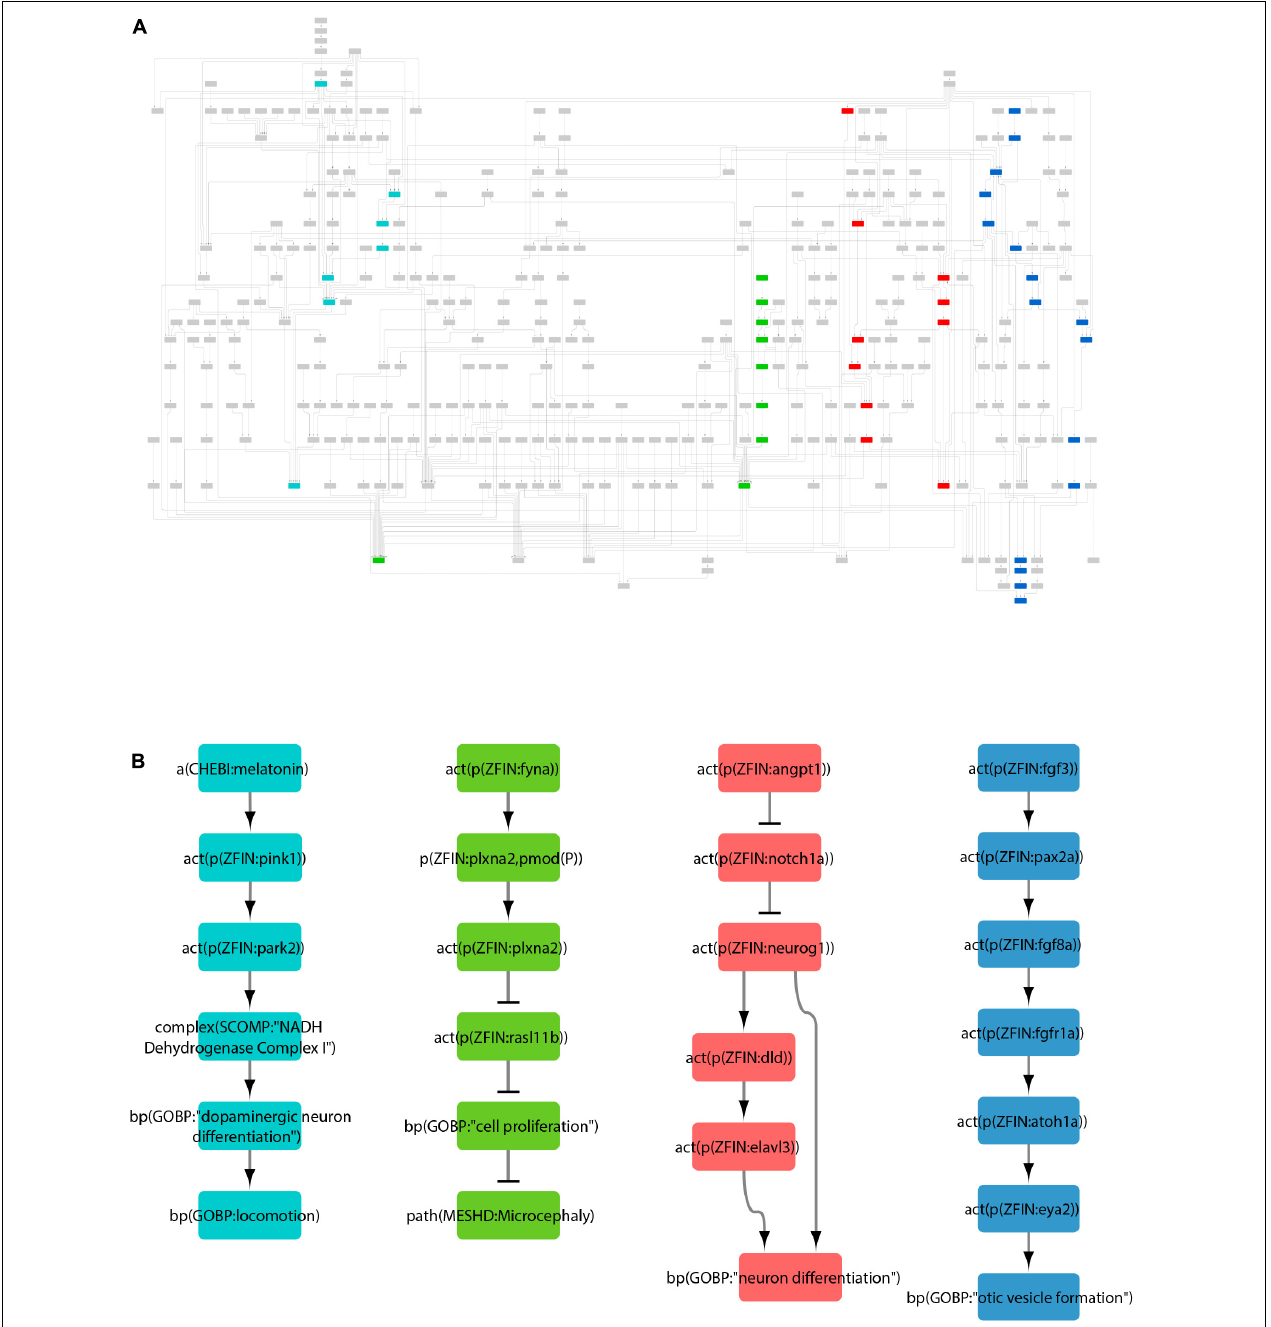
FIGURE 2 | The zebrafish neurotoxicity network. (A) The entire network visualized in Cytoscape. (B) Selected pathways extracted from the network and color-coded to nodes in panel A. To simplify visualization, RNA, protein, and protein activity nodes were collapsed into a single corresponding